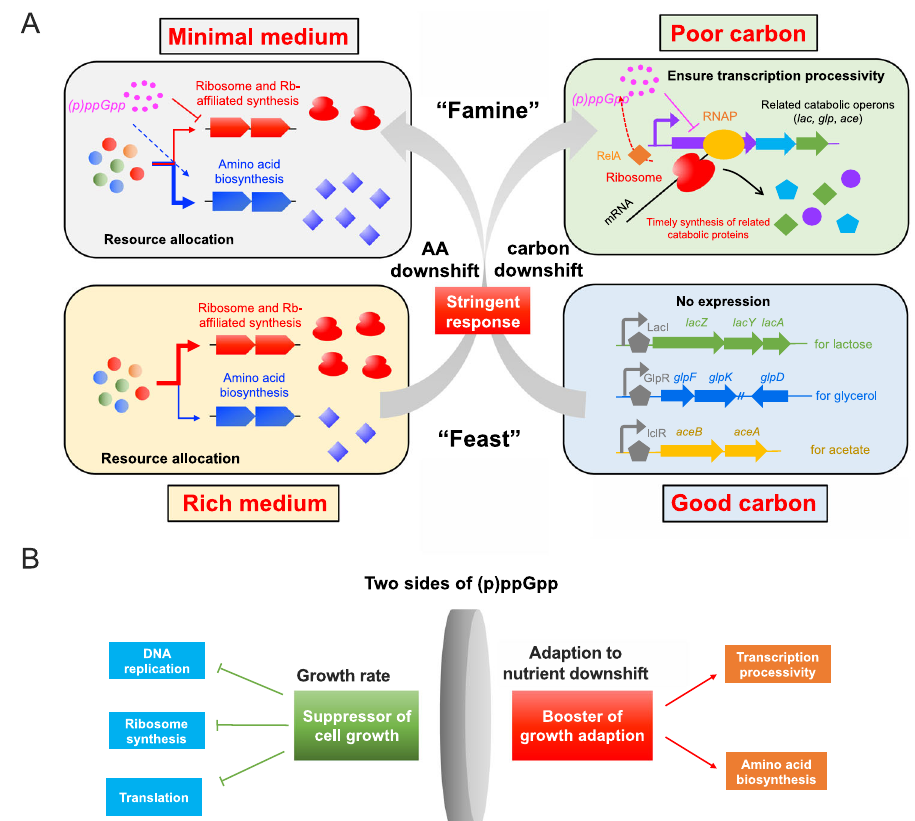
Fig. 8 | Schematic illustration of theroleof(p)ppGpp inboosting theadaption of bacterial growth to nutrient downshift. A From “ feast ” to “ famine ” , stringent response plays an important role in ensuring the timely adaption of bacterial growth to nutrient downshift. During amino acid downshift (rich medium to minimal medium), (p)ppGpp promotes the growth adaption of bacterial via acti- vating amino acid biosynthesis. In the case of carbon downshift, the RelA- dependent (p)ppGpp stringent response maintains the transcription-translation coordination and further ensures the transcription processivity so that related catabolic proteins of speci fi c carbons (e.g., lactose, glycerol and acetate) could